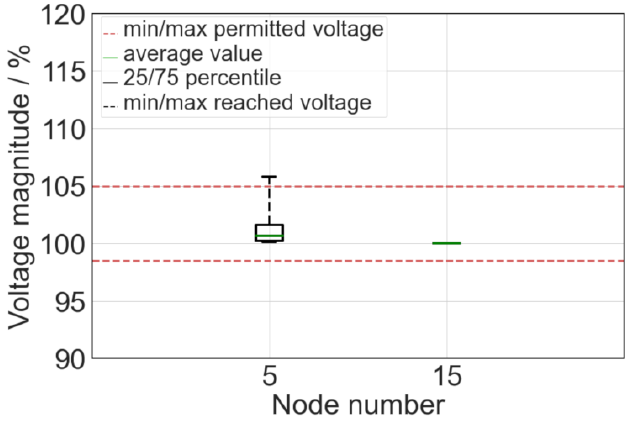
Figure 11. Voltage magnitude on some nodes of the MV grid.